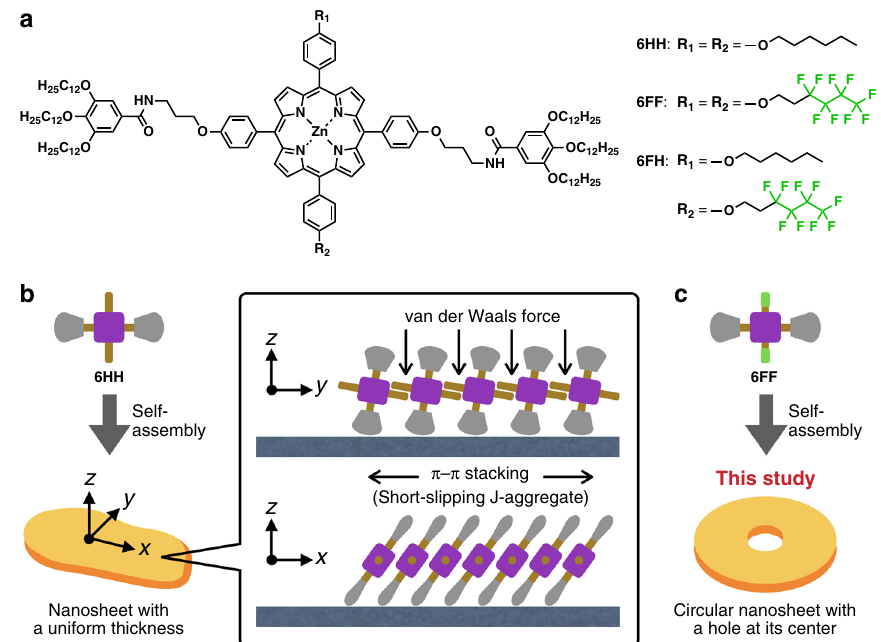
Fig. 1 Molecular design and self-assembly. a Molecular structures of 6HH , 6FF , and 6FH used in this study. b Schematic representation of self-assembly of 6HH to form a supramolecular nanosheet. Before our present study, we expected that 6FF would form a supramolecular nanosheet, similar to that formed by 6HH , but with a different aspect ratio as a result of differences in intermolecular interactions along the y -axis. c Schematic representation of a supramolecular circular nanosheet with a hole at its center formed from 6FF